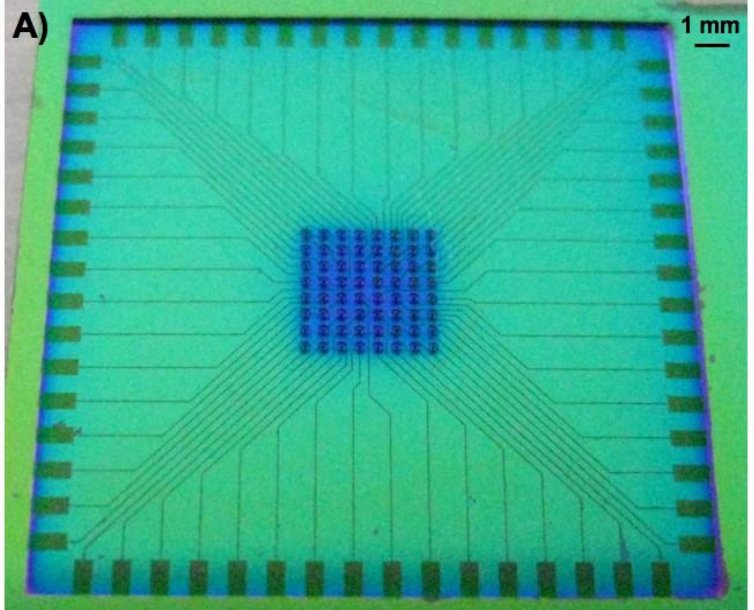
Figure 3. (A ) Patterned polymer film on a silicon nitride surface (dark areas). The microchip included pads for electrical connections, conductive paths, and areas with 3D pillar electrode structures; ( B ) SEM top-view image of one of the pads; ( C ) SEM top-view image of areas with 3D microstructures. SEM images were obtained using a FEI Nova 600 NanoSEM system (FEI Company, OR,